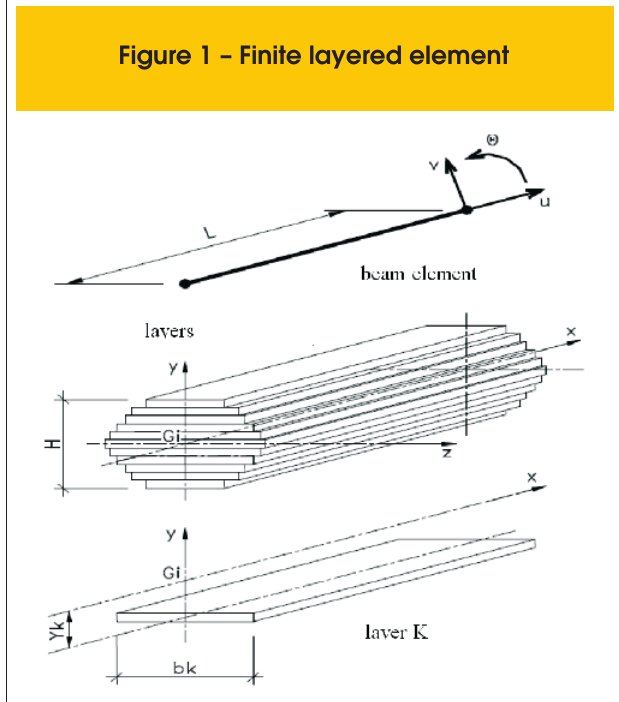
Figure 1 – Finite layered